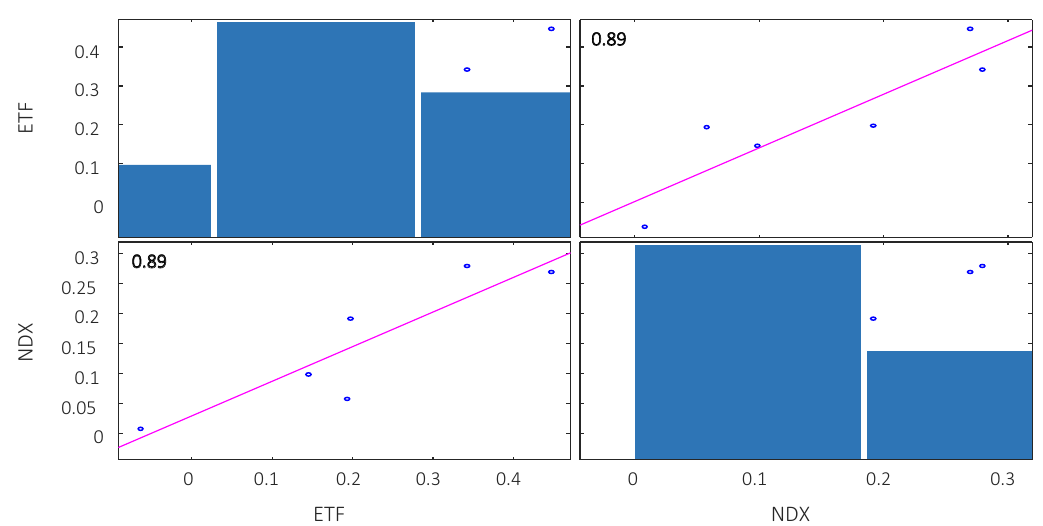
Figure 4. A matrix of plots showing the correlations between variables ETF, US